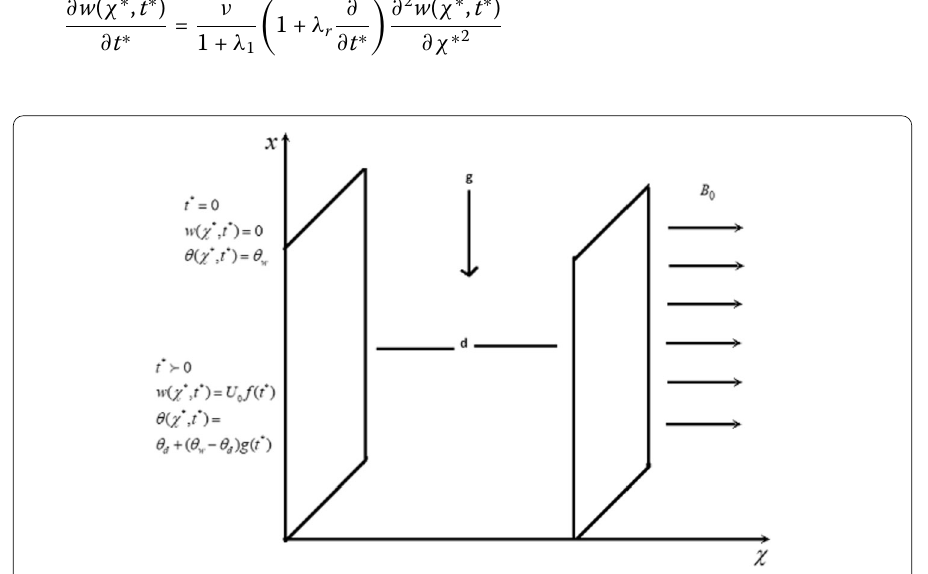
Figure 1 Model geometry with